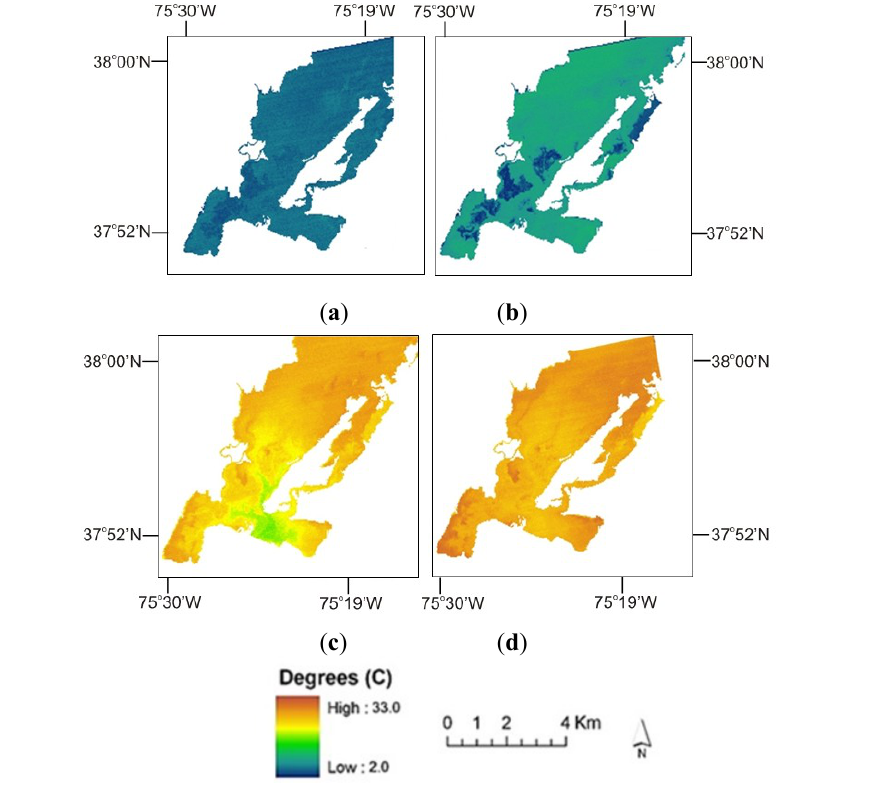
Figure 4. ASTER time series surface temperature for water surfaces masked from land and transformed to skin surface temperature ( a ) 19 February 2005, ( b ) 19 March 2006, ( c ) 23 May 2004, and ( d ) 3 July